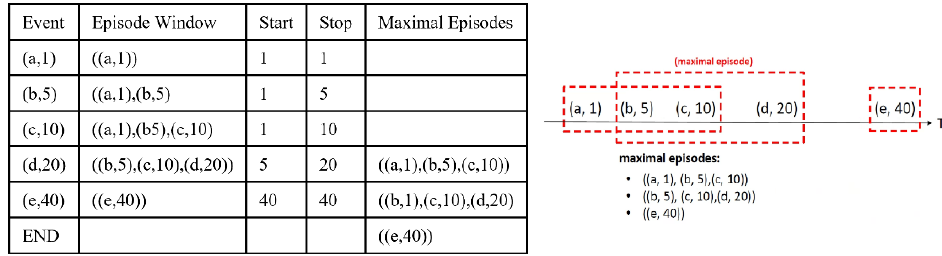
Figure 6. Example of event sequence segmentation.